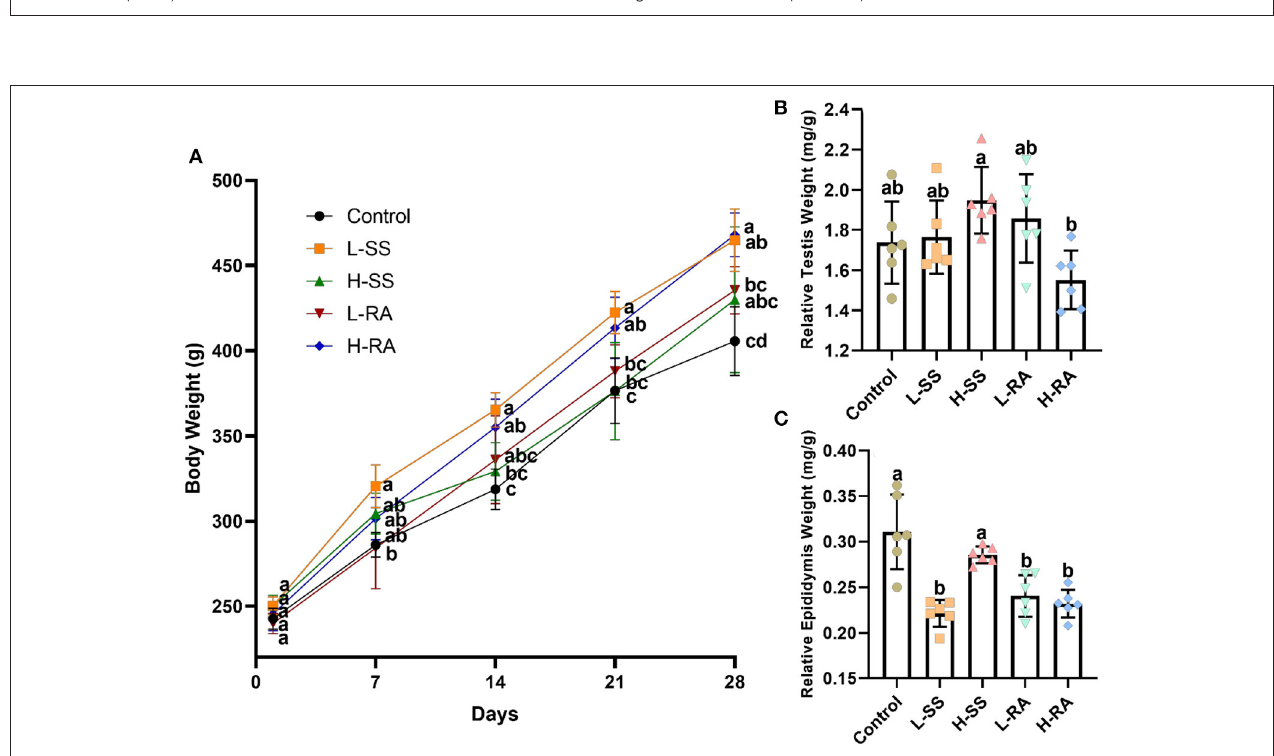
FIGURE 2 | Effect of dietary non-nutritive sweetness drinking on body weight, relative testis weight, and epididymis weight (testis weight or epididymis weight/body weight) in male guinea pigs. Animals in control, L-SS, H-SS, L-RA and H-RA groups were supplied water solution with normal water, 1.5mM sodium saccharin, 7.5mM sodium saccharin, 0.5mM rebaudioside A, and 2.5mM rebaudioside A for 28 days, respectively. Each point in (A) represents average body weight at days 1, 7, 14, 21, and 28, testis (B) , and epididymis (C) weights were measured at day 28. Data are shown as means ± SD ( n = 6). Points in the same vertical line on (A) with different letters denote significant differences ( P < 0.05), bars shown on (B,C) with different letters denote significant differences ( P < 0.05).